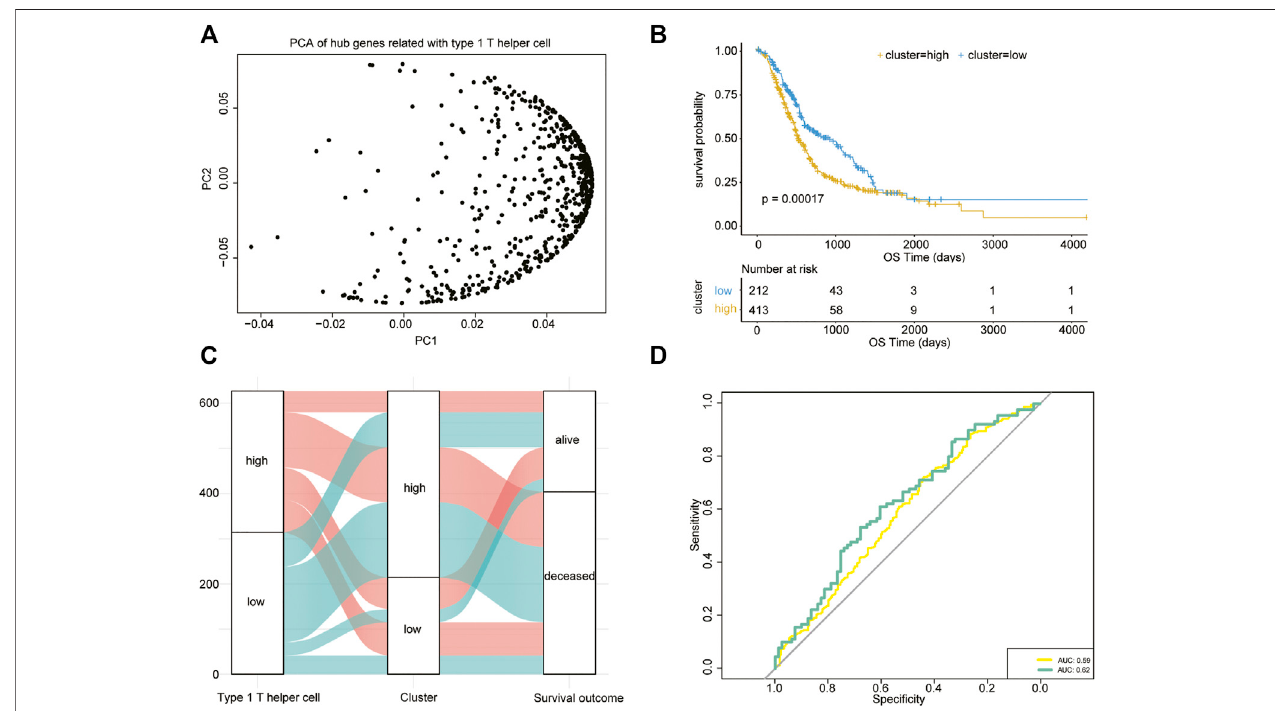
FIGURE 5 | Type 1 T helper cell – related signature-based risk score calculation. (A) PCA of the key type 1 T helper cell – related genes. (B) Univariate Cox analysis and Kaplan – Meier curves show prolonged survival in patients with low risk scores compared with patients with high risk scores. (C) A Sankey plot is used to reveal the correlation between type 1 T helper cell scores, prognostic signature-based risk scores, and clinical outcome. (D) AUC estimation for the risk score model (yellow line) and incorporation of T stage into the risk score model (green line). Abbreviations: PCA, principal component analysis.